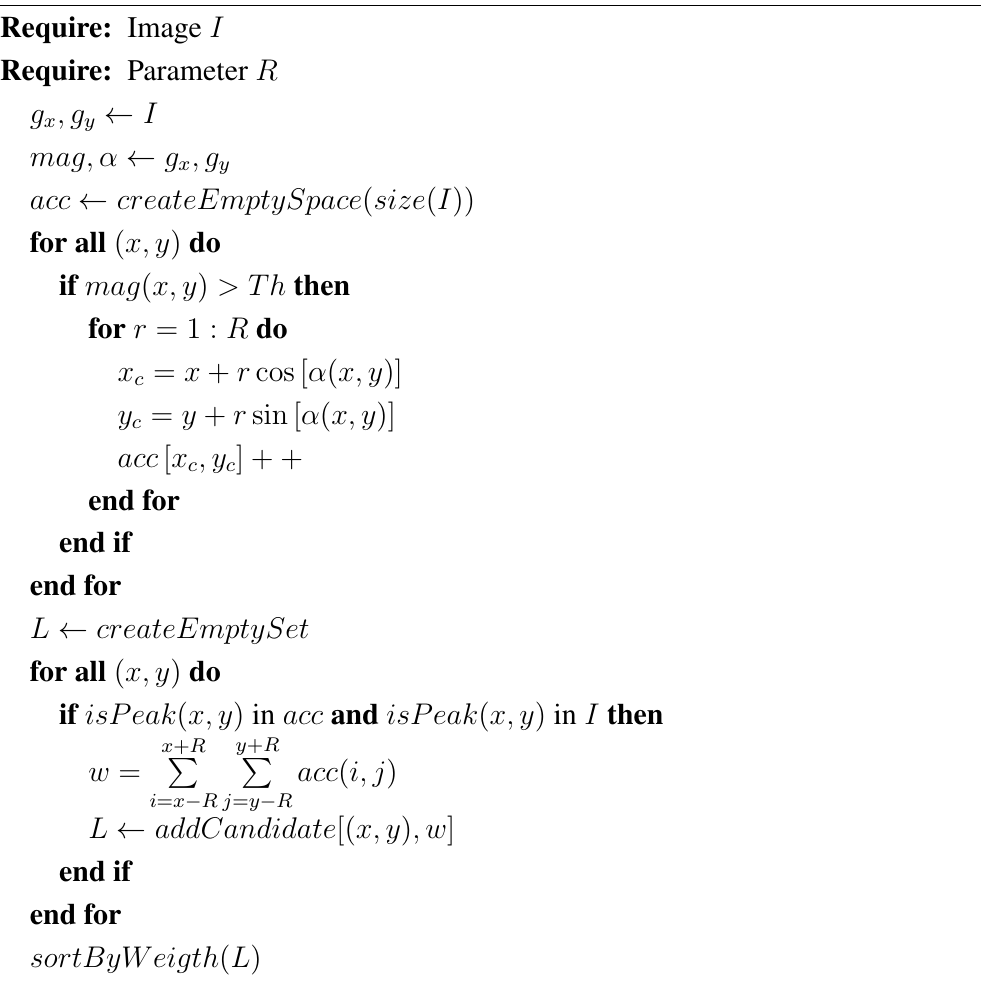
Algorithm 1 Detect laser spot